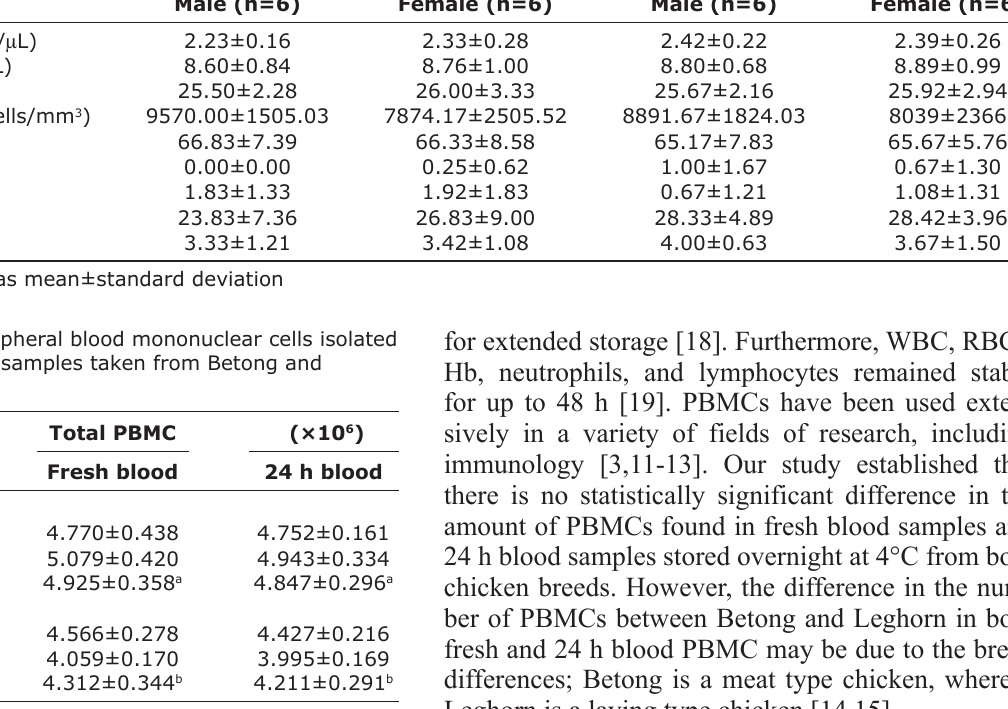
Table-1: Hematological values of Betong (n=12) and Leghorn (n=12) chickens. Hematological values